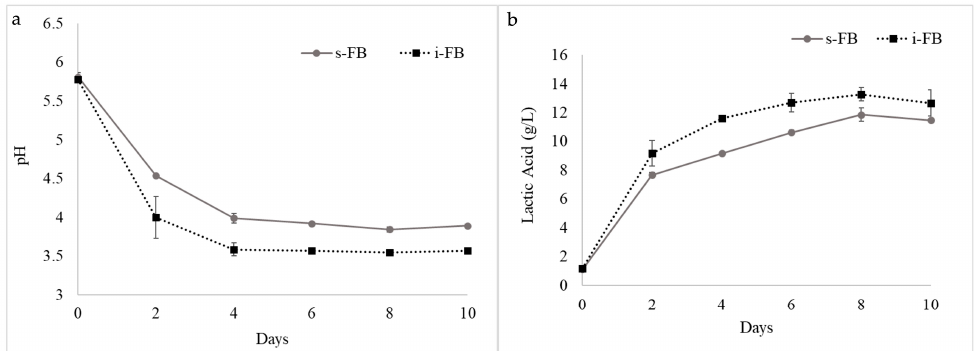
Figure 2. ( a ) Change in pH value of broccoli fermented spontaneously (s-FB) and by starter cultures (i-FB) over 10 days. ( b ) Quantification of lactic acid of broccoli fermented spontaneously (s-FB) and by starter cultures (i-FB) over 10 days. Error bars represent the standard deviations of three replicates.